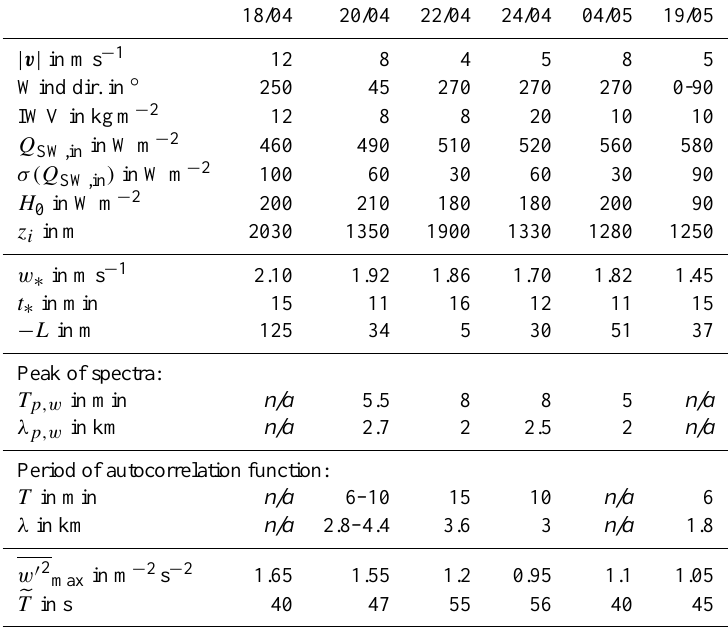
Table 2. Overview of characteristic mean values and scales for all considered days (spatially averaged for surface measurements and tur- bulence characteristics, Hambach for other variables): Diurnal maximum of surface sensible heat flux H 0 and of boundary-layer height z i ; daily mean values of integrated water vapor IWV, of spatial mean and standard deviation of incoming shortwave radiation Q SW,in , of mean boundary-layer wind speed | v | , and of wind direction; diurnal maximum of convective velocity scale w ∗ , of corresponding convective time scale t ∗ , and diurnal mean of Obukhov length L ; estimated peak wavelength of turbulence spectra in 600m height (10:00–17:00UTC), λ p,w = | v | f − 1 p,w (using Taylor’s hypothesis), with time scale T p,w = f − 1 p,w , and the period T of the autocorrelation function with correspond- ing wavelength λ (denoted as n/a when no estimation was possible); diurnal mean of w (cid:48) 2 max and of integral time scale e T (same height as w (cid:48) 2 max